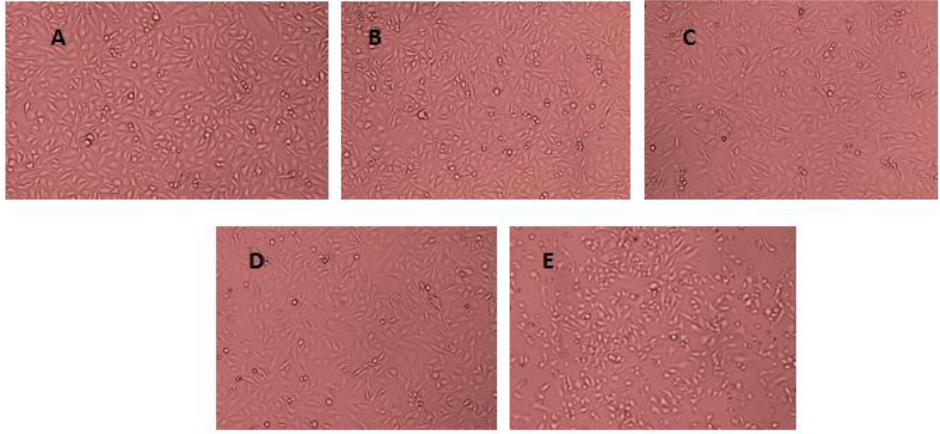
Figure 3. Morphological changes in HUVECs observed under an electron microscope after 24 h of exposure to B[a]P and/ SiNPs. ( A ) Control group; ( B ) HUVECs exposed to DMSO (0.1%); ( C ) HUVECs